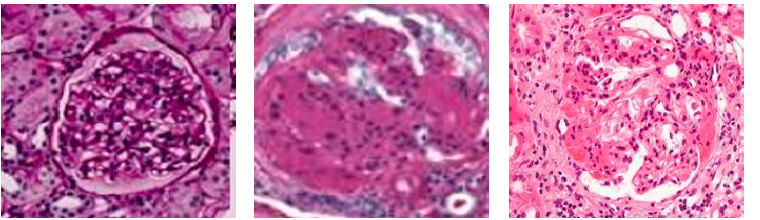
Figure 1. Anatomies of normal glomeruli, sclerosed glomeruli and focal-segmental glomeruli. ( Left ) Normal glomeruli; ( Center ) sclerosed glomeruli and ( Right ) focal-segmental glomeruli.